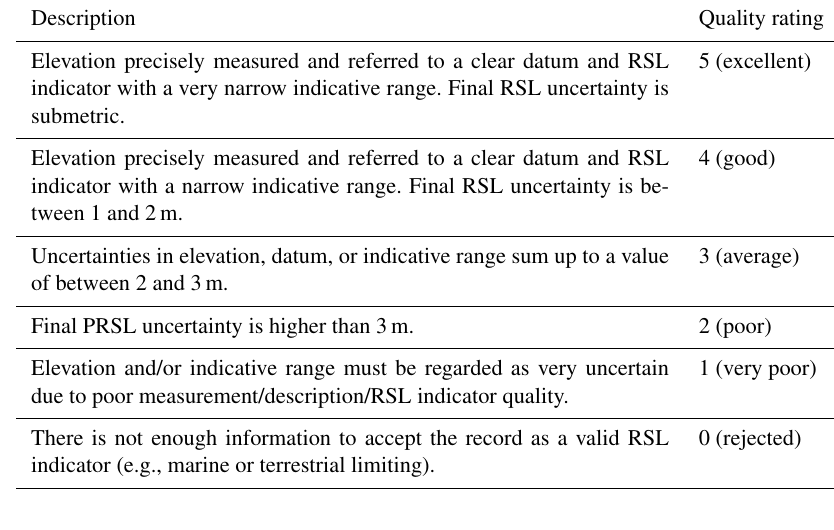
Table 5. Quality rating guidelines used for evaluating age information. Exported from WALIS (Rovere et al., 2020). Description Quality